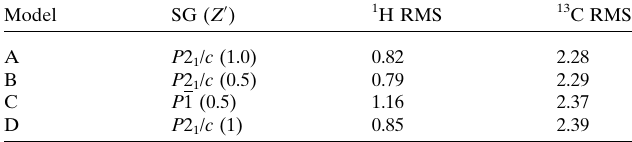
Table 10 1 H and 13 C SSNMR RMS deviation between calculated and experimental chemical shifts (p.p.m.) for structures A–D. For the calculation of the SSNMR shifts, the crystal structures were optimized with a fixed unit